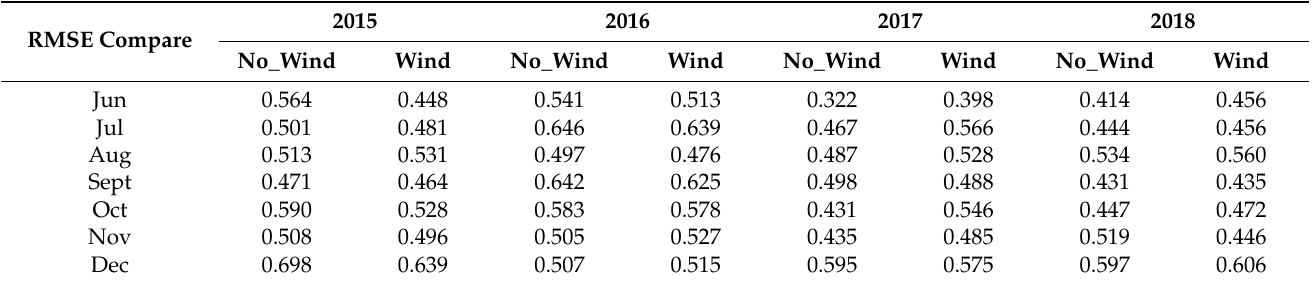
Table 2. RMSE of the no_wind convLSTM model and convLSTM model with wind field data.